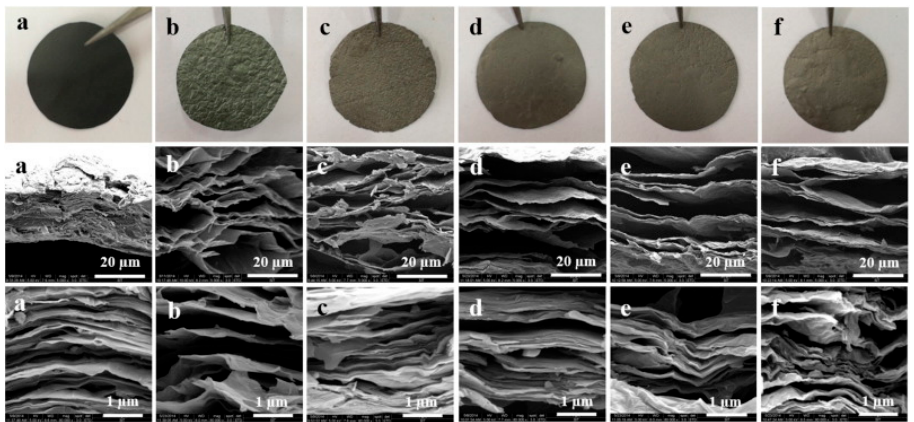
Figure 5. Visual (top), low-magnification SEM (middle), and high-magnification SEM (bottom) images of ( a ) GO film; ( b ) rGO film with HI recution; ( c ) rGO film with HI reduction + 600 °C reduction; ( d ) rGO film with 600 °C reduction; ( e ) rGO film with 800 °C reduction; and ( f ) rGO film with 1000 °C reduction. Reprinted from [48] with permission; Copyright 2015 Elsevier.